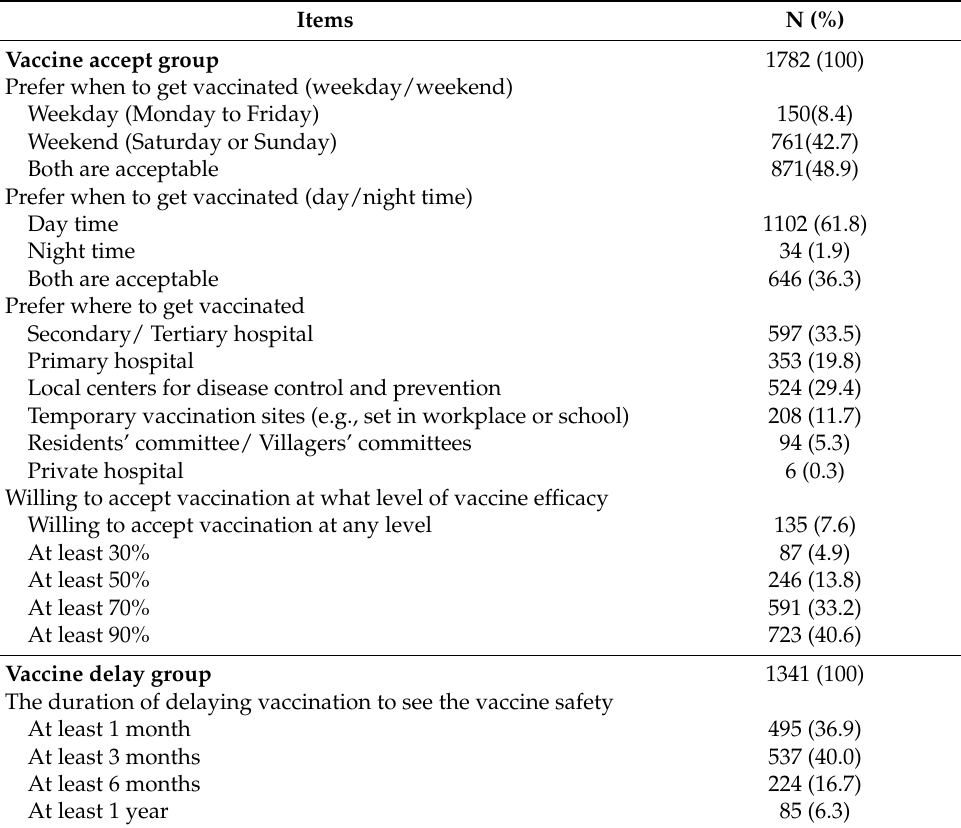
Table 3. Preferences for COVID-19 vaccination among respondents in the well-contained